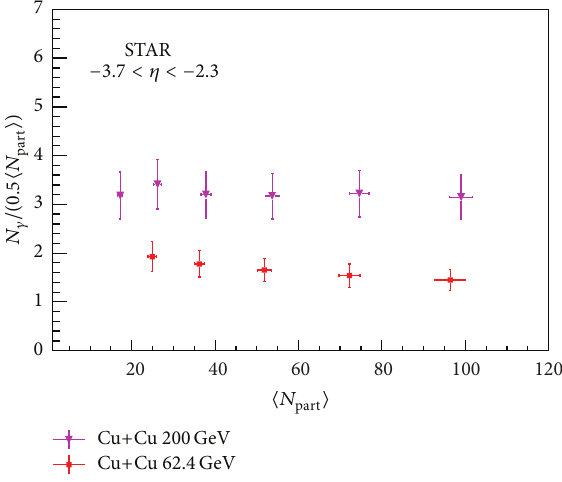
Figure 32: 𝑅 of photons as a function of 𝜂 󸀠 = 𝜂−𝑦 PC collisions for different energies.